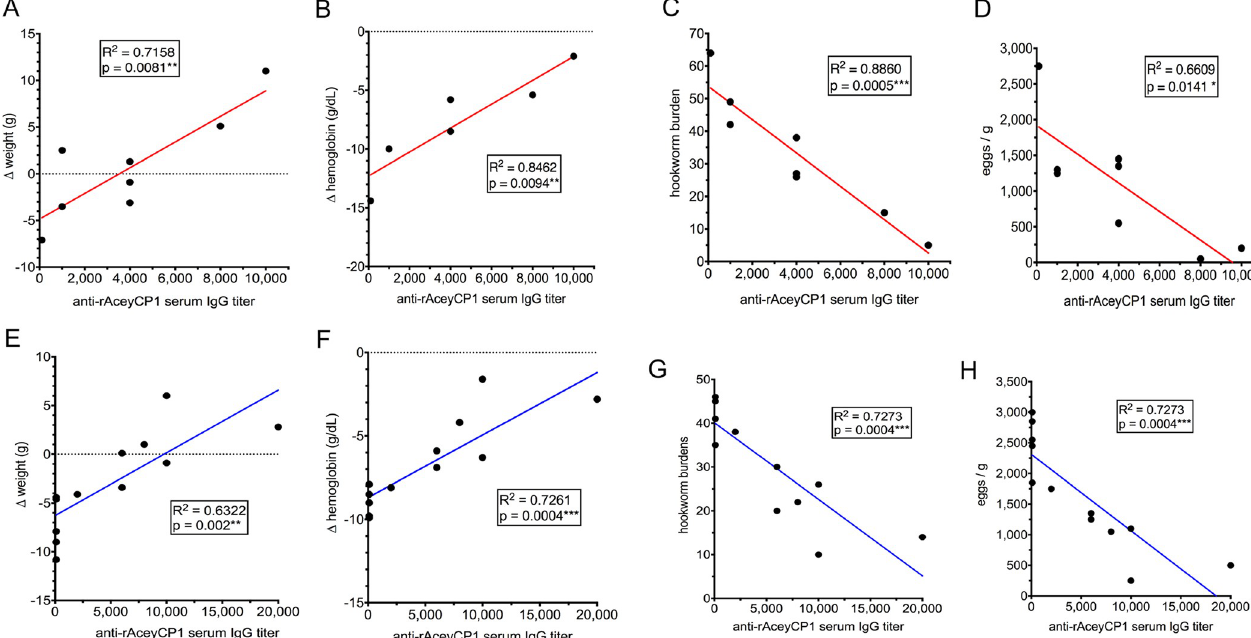
Fig 8. Linear regression of two measures of sequelae and two measures of infection status by rAceyCP1 serum IgG titer. (A-D) Vaccine trial 1. (E-H) Vaccine trial 2.